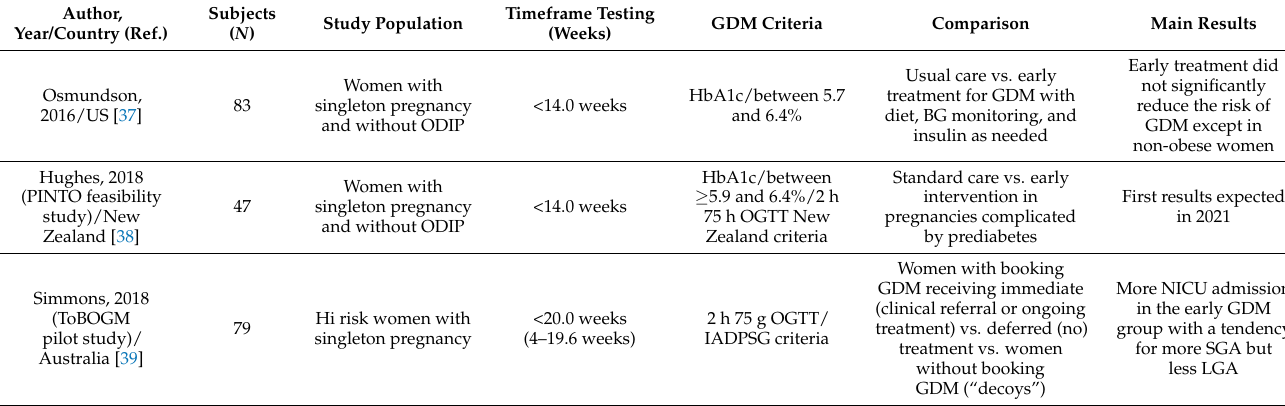
Table 2. Randomized controlled